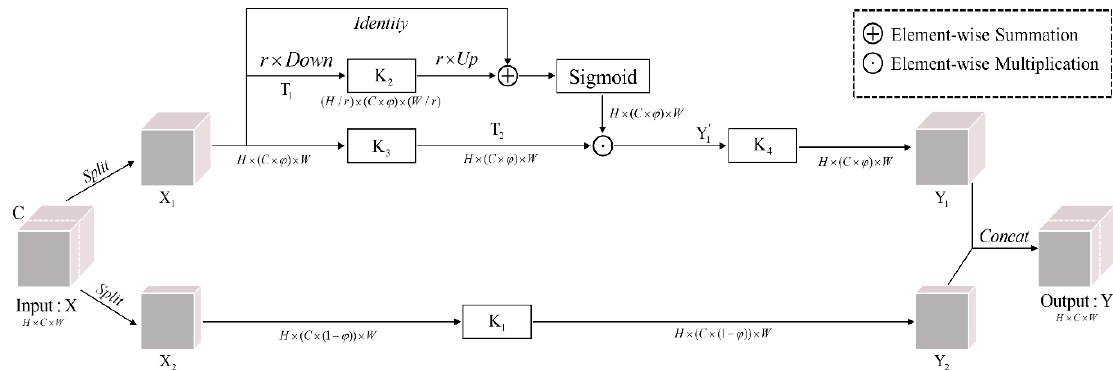
Figure 3. The improved SC-conv structure.